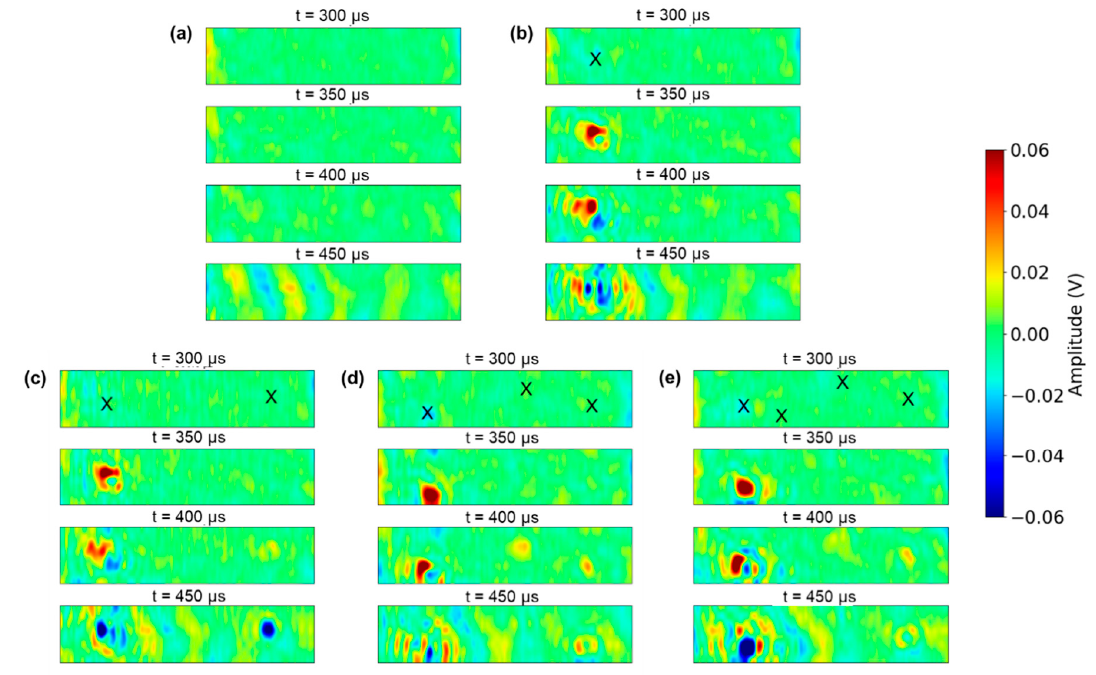
Figure 8. Extracted non-propagating oscillatory fields: ( a ) Case 0 (pristine), ( b ) Case 1 (D1 only), ( c ) Case 2 (D1 and D2), ( d ) Case 3 (D1 to D3) and ( e ) Case 4 (D1 to D4). The wavefield images each represent a 250 mm (horizontal) × 49 mm (vertical) scan area. ‘X’ indicates impact damage locations. Normalized non-propagating wave energy maps, 𝐸 (cid:3015)(cid:3017)(cid:3016)(cid:3015) (𝑥, 𝑦) , for all the tested concrete sample